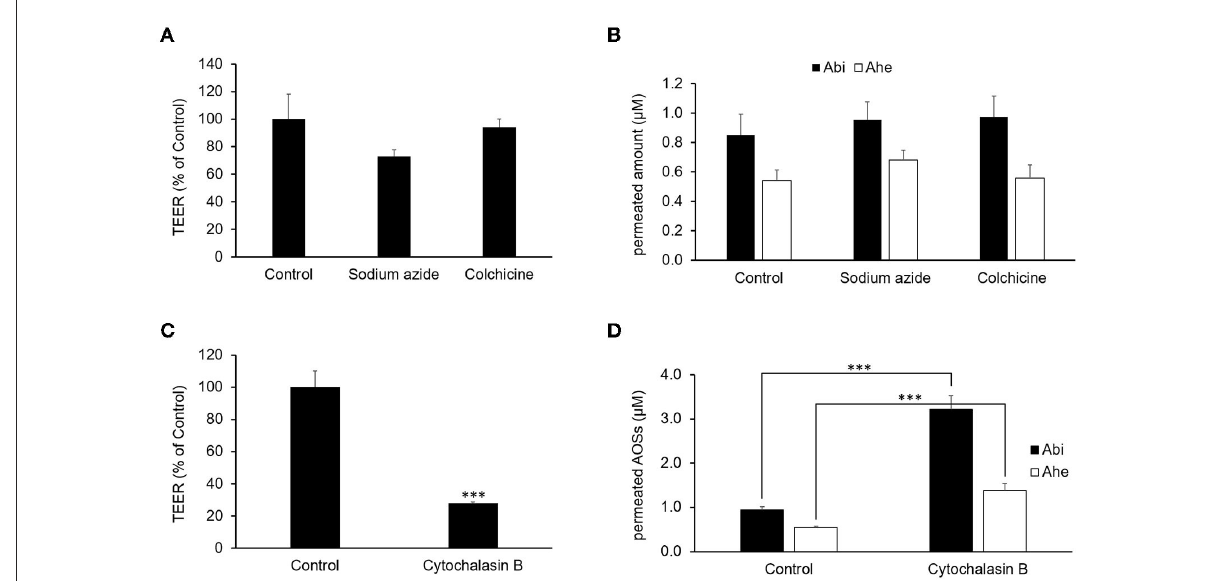
FIGURE5 Effects of sodium azide, colchicine, and cytochalasin B on the permeability of AOSs across the Caco-2 cell monolayers. Sodium azide, colchicine, or cytochalasin B was added to the apical chamber 30min before adding Abi and Ahe. After incubation for 2h, the TEER (A,C) and amount of permeated Abi and Ahe in the basolateral chamber (B,D) were measured. Each value represents the mean ± SE ( n = 3). The three asterisks (***) correspond to P < 0.001 vs. the